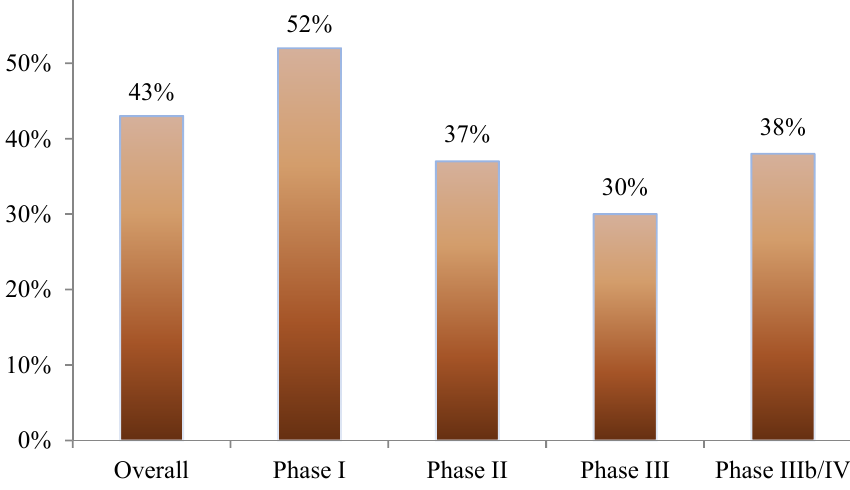
Figure 1. Proportion of protocol amendments occurring before the patient has received the first